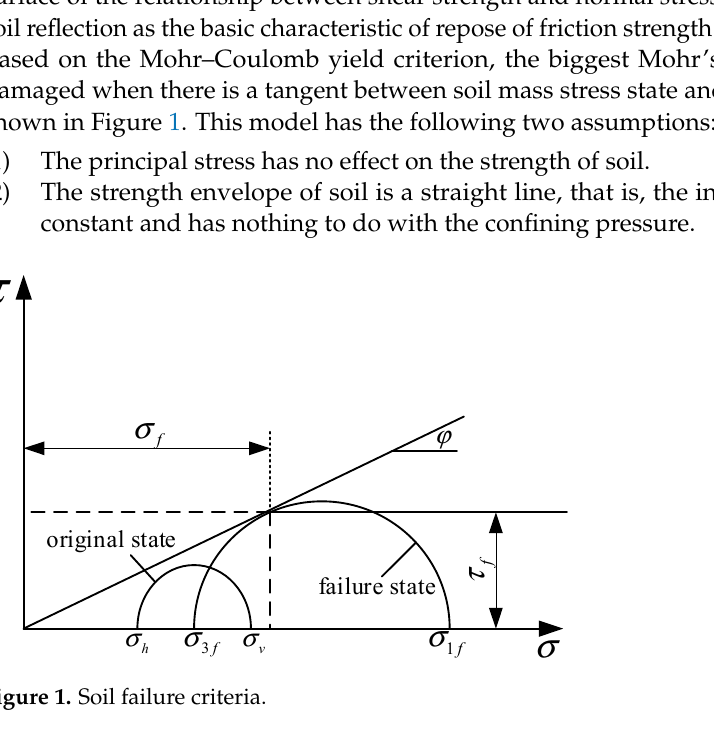
Figure 1. Soil failure criteria.